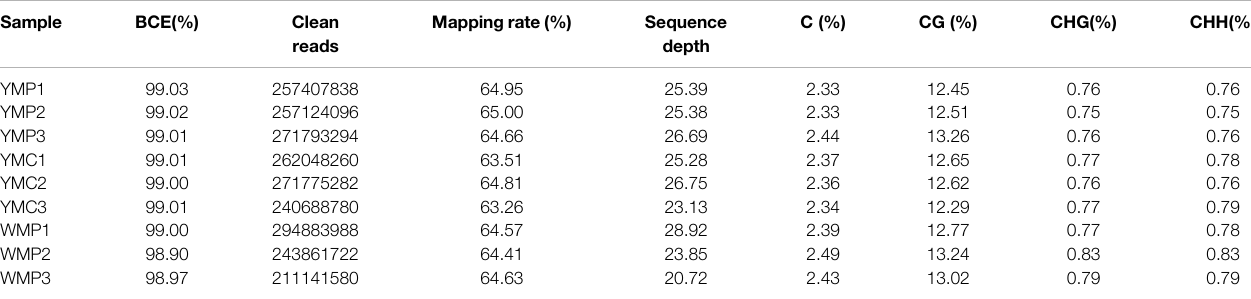
TABLE 2 | Read quality and genome coverage of